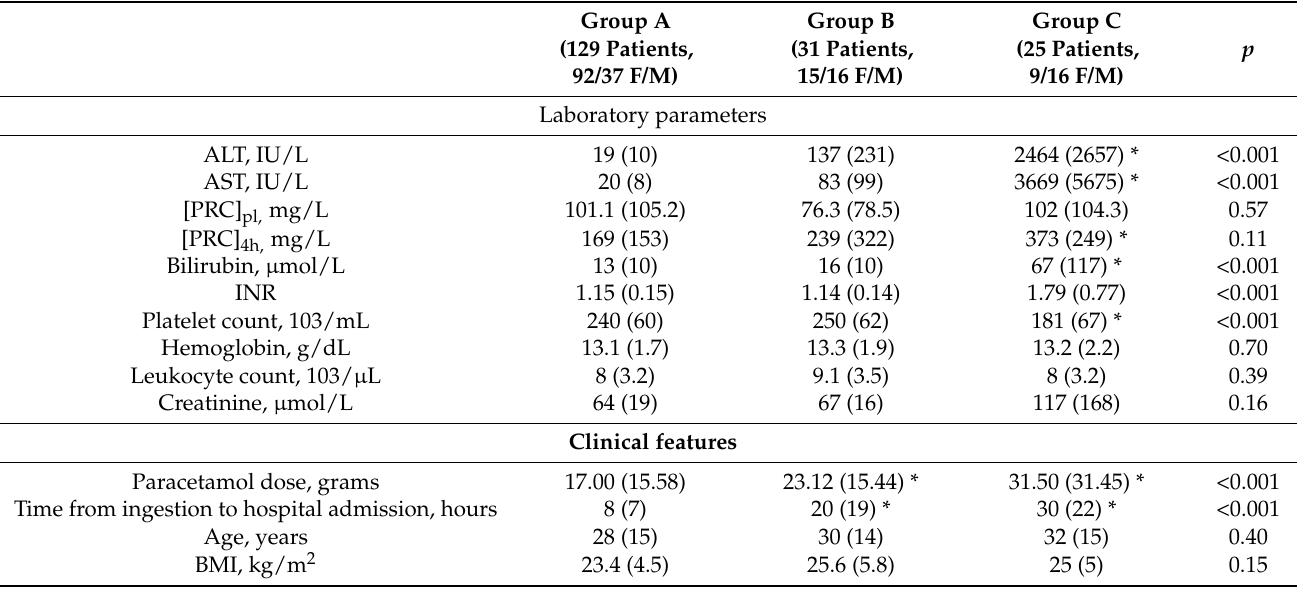
Table 1. Quantitative clinical and laboratory variables characterizing groups A, B, and